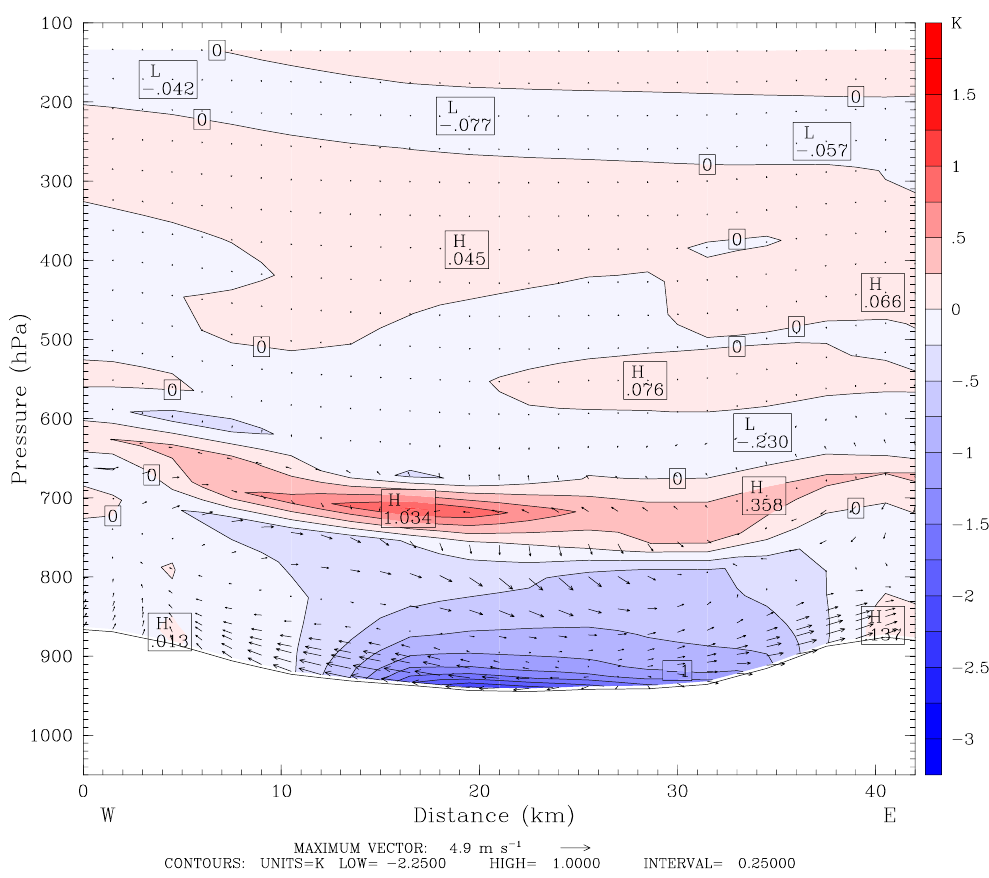
Fig. 5. East-west vertical cross section of wind difference between the SUMWF lake and corresponding no-lake case at 02 July 1999, 12:00GMT. The cross section is taken across the middle of the lake. Units are m/s. for the daytime (08:00 GMT to 19:00 GMT) and nighttime (20:00 GMT to 07:00 GMT) conditions in the winter